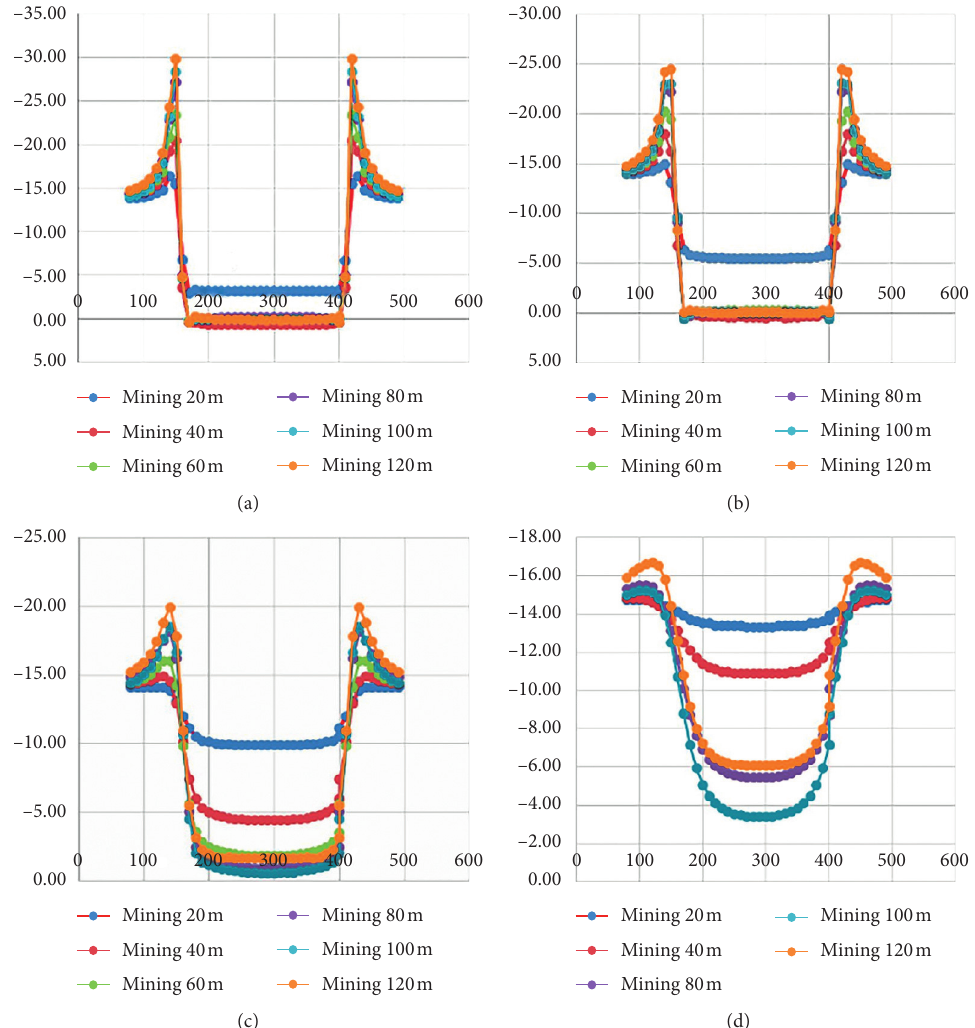
Figure 4: Stress variation under the same floor depth with different stoping distances. (a) Floor 1m. (b) Floor 5 m. (c) Floor 15 m. (d) Floor